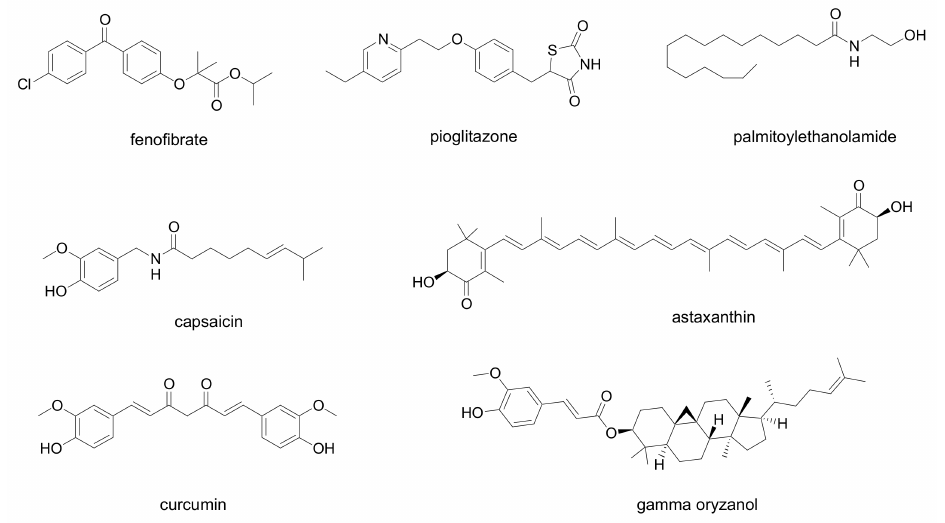
Figure 3. Chemical structures of natural and synthetic PPAR ligands explored in in vitro assays or proposed as possible antiviral agents against SARS-CoV-2